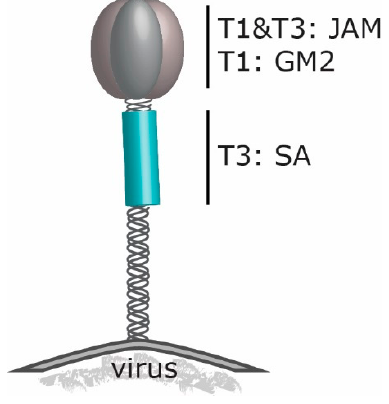
Figure 1. Schematic model of the σ 1 trimer at the reovirus capsid. Depicted are the receptor-binding regions of T3D (T3) and T1L (T1). JAM: JAM-A (Junction Adhesion Molecule-A), GM2: ganglioside M2, SA: α 2,3; α 2,6 and α 2,8-linked sialic acid.